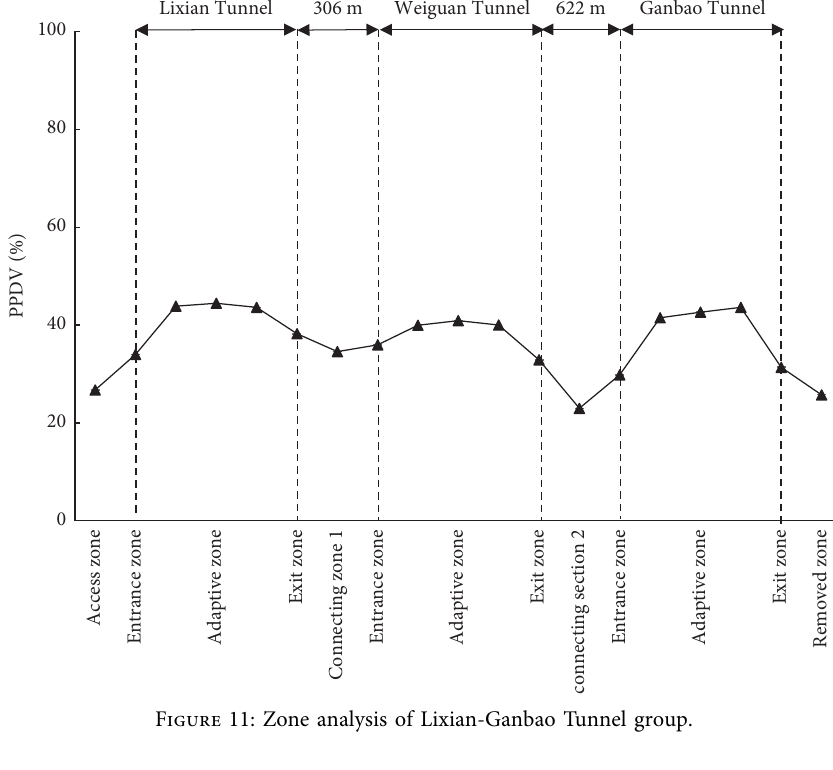
Figure 11: Zone analysis of Lixian-Ganbao Tunnel group.